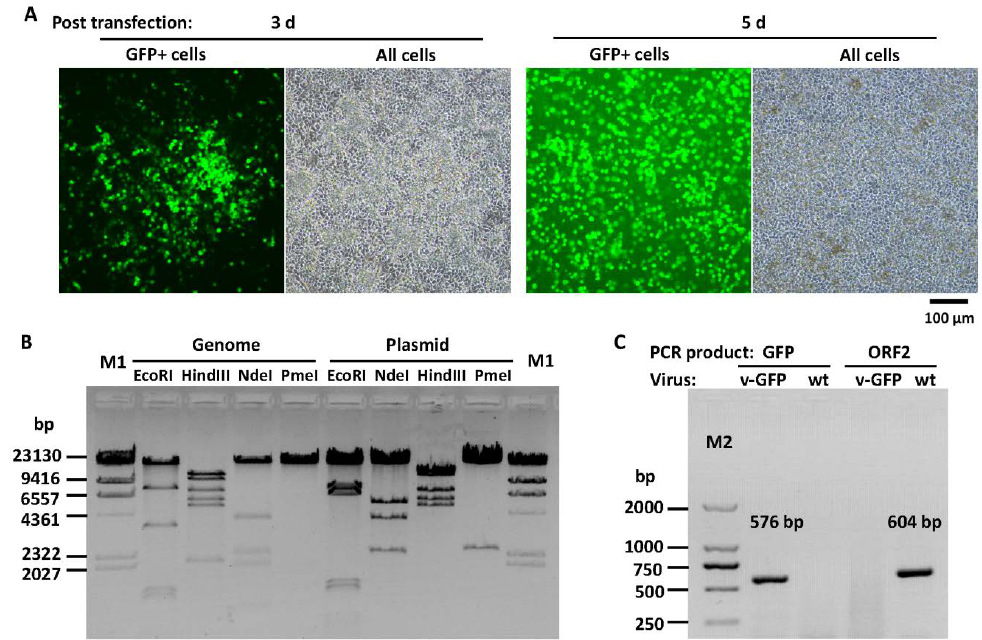
Figure 3. FAdV4-GFP rescue and identification. ( A ) Rescue of recombinant fowl adenovirus